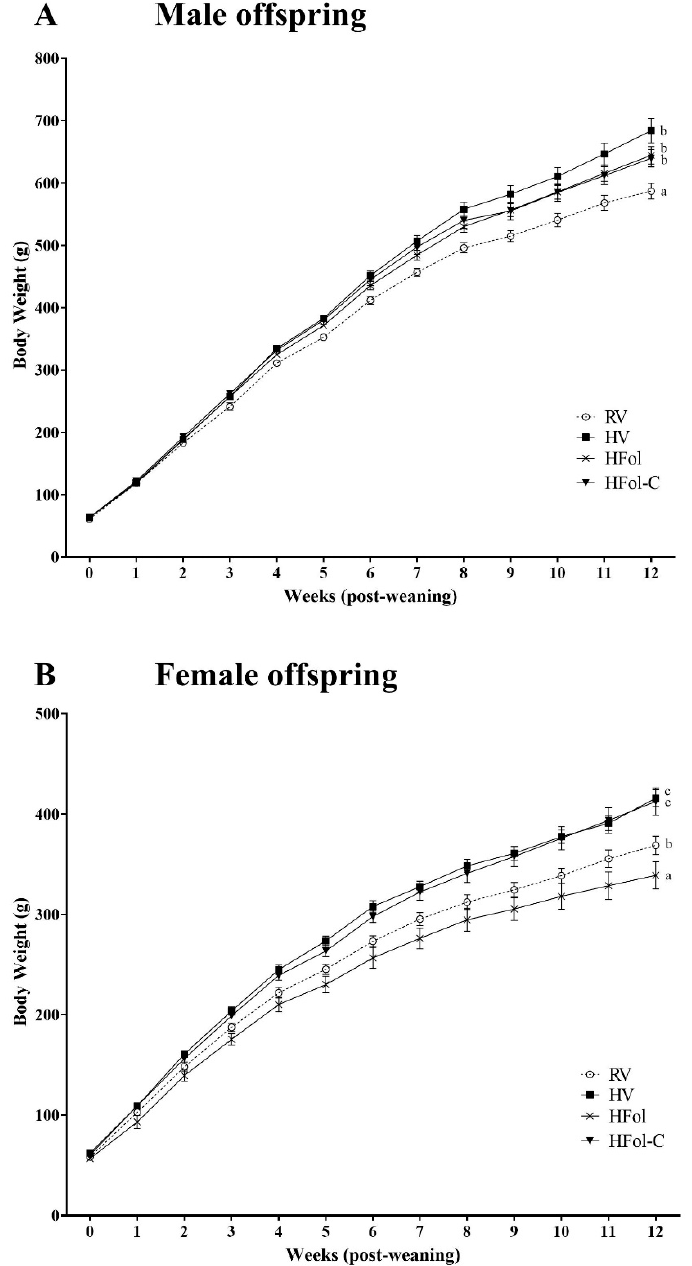
Figure 2. Body weight, in grams, in ( A ) male and ( B ) female offspring from 0-12 weeks post-weaning. Diet abbreviations: RV, recommended vitamin; HV, high multivitamin; HFol, high folic acid with recommended choline; HFol-C, high folic acid without choline. ( A ) Diet p = 0.0002, Time p < 0.0001, Diet ∗ Time p < 0.0001. ( B ) Diet p < 0.0001, Time p < 0.0001, Diet ∗ Time p < 0.0001. Superscripts indicate significant difference by PROC MIXED model repeated measures followed by the Tukey– Kramer post hoc test, n = 10–12/group. Values are mean ± SEM.